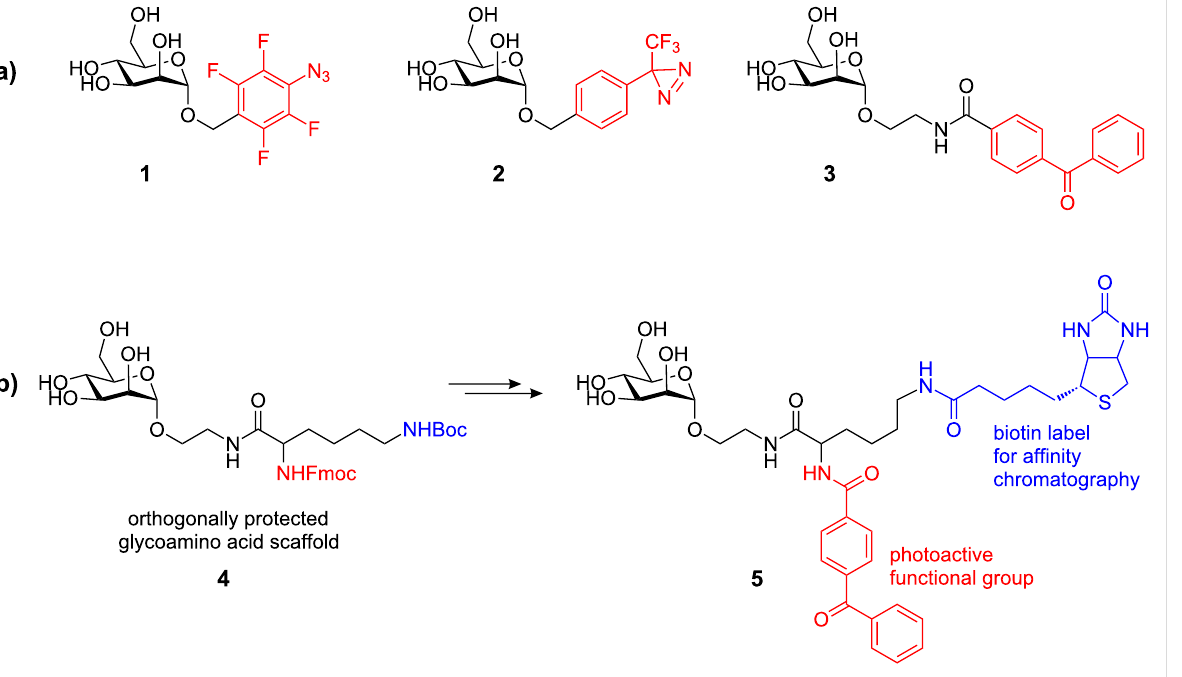
Figure 2: a) Three known photolabile α -D-mannosides that differ in the nature of the photoactive functional group (in red); b) the known bifunctional mannoside ligand 5 is based on the orthogonally protected glycoamino acid 4 and well suited for photoaffinity labeling.